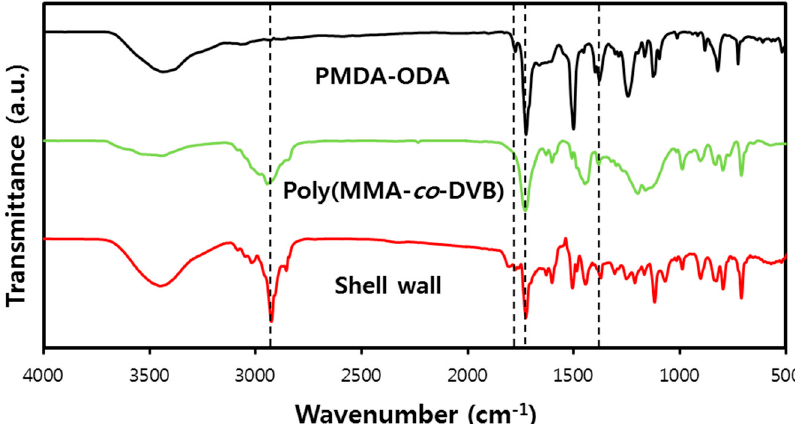
Figure 10. FT-IR spectra of PMDA-ODA, poly(MMA- co -DVB), and the shell wall. The shell wall sample was obtained by pressing the microcapsules between two slide glasses and drying.